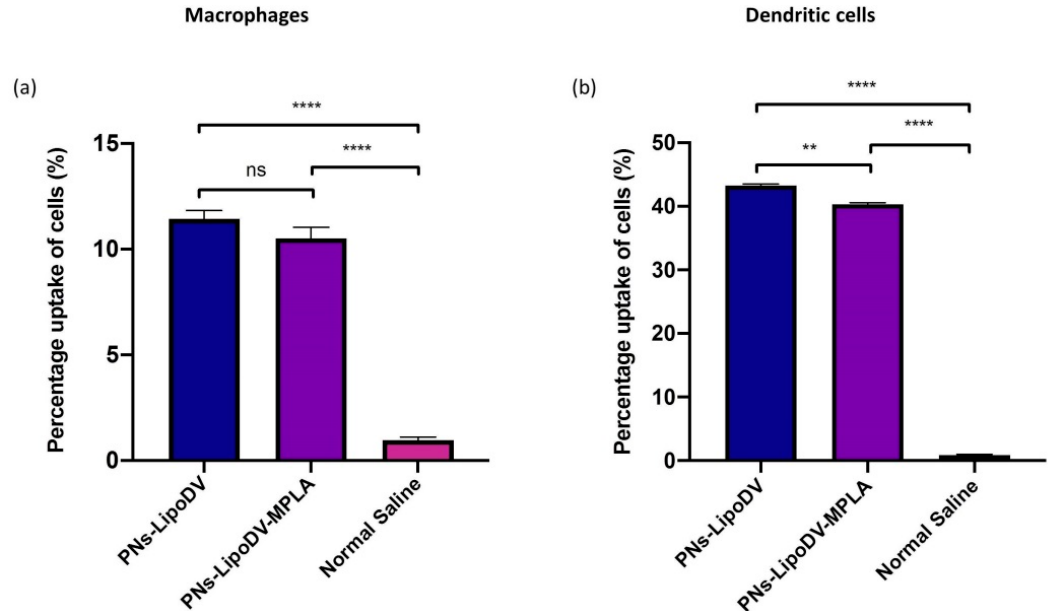
Figure 3. Macrophage ( a ) and dendritic cell ( b ) uptake analysis for PNs-LipoDV, PNs-LipoDV-MPLA and normal saline (negative control). Bars represent the mean and standard deviations of the percentage of cell marker positive for each group. The differences between the groups were analyzed using one-way ANOVA and post hoc Tukey test (ns, p > 0.05; ** p < 0.01; **** p < 0.0001). The cytotoxicity of PNs-LipoDV and PNs-LipoDV-MPLA vaccines was assessed on human embryonic kidney cells (HEK293) by MTT assay. PNs-based formulated vaccines concentrations were considered non-toxic when cell viability after 48 h of incubation